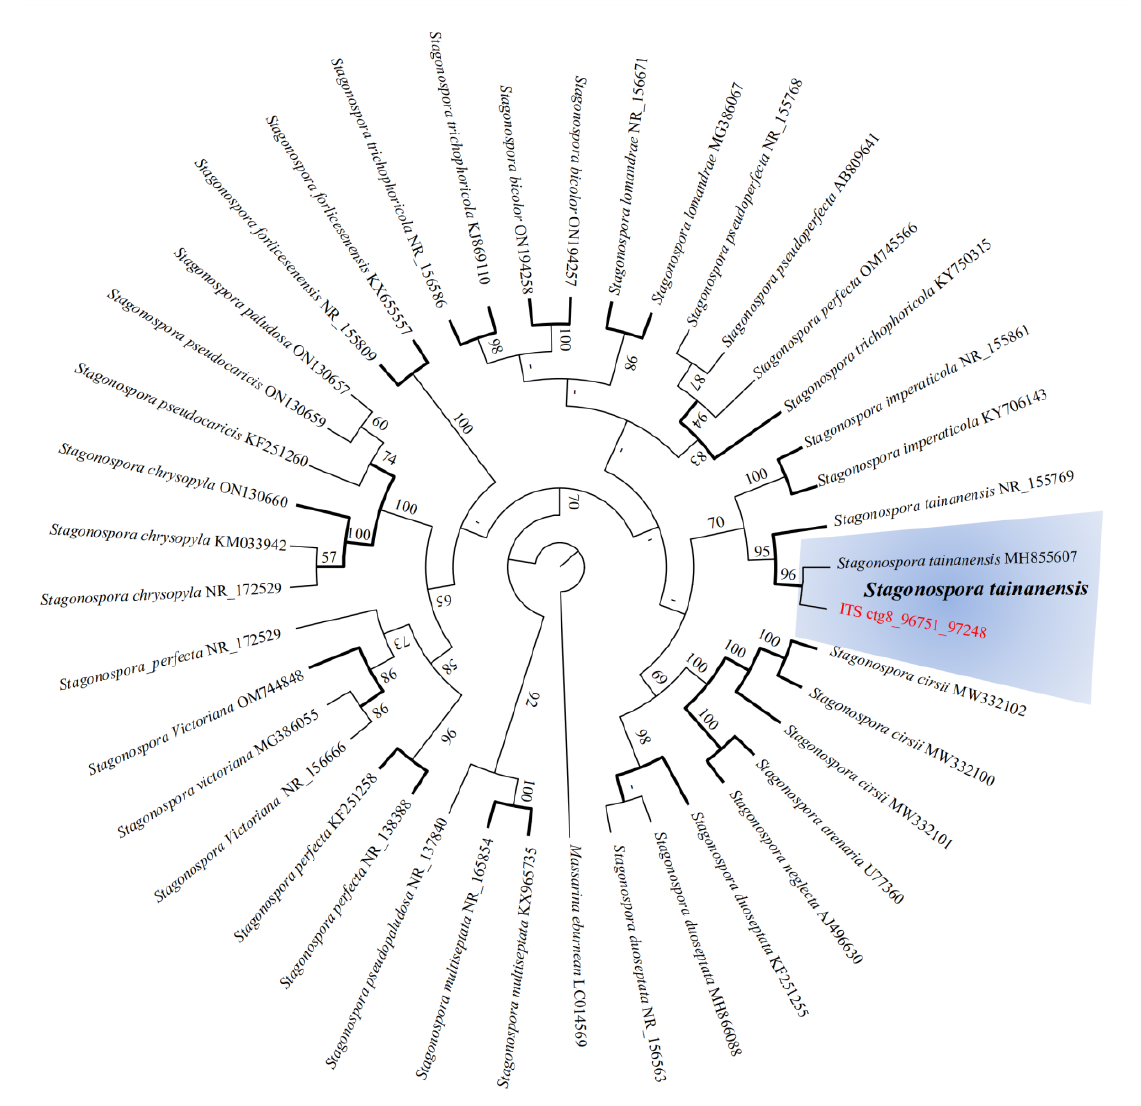
Figure 1. The species of strain StFZ01 was verified as Stagonospora tainanensis by maximum likelihood phylogenetic tree analysis (bootstrap = 1000) conducted by MEGA v11 (https://www.megasoftware.net/) (accessed on 17 August 2022) based on ITS sequences with high similarity collected from NCBI. Table S1 Summary of sequencing